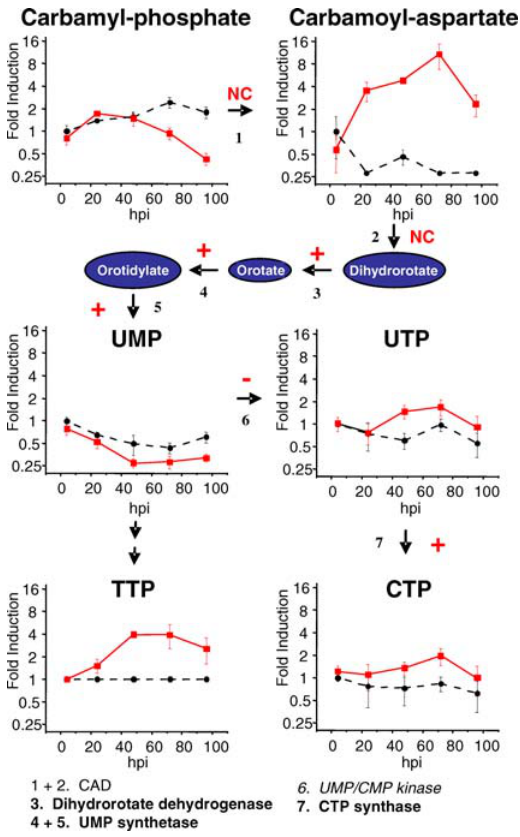
Figure 4. HCMV-Induced Changes in Pyrimidine Biosynthesis Metabolite data from mock-infected (dotted line) or virally infected (red line) fibroblasts are plotted, with the symbols þ , (cid:1) , and NC (shown in red) over the arrows indicating changing levels of enzyme transcripts as described in the Figure 1